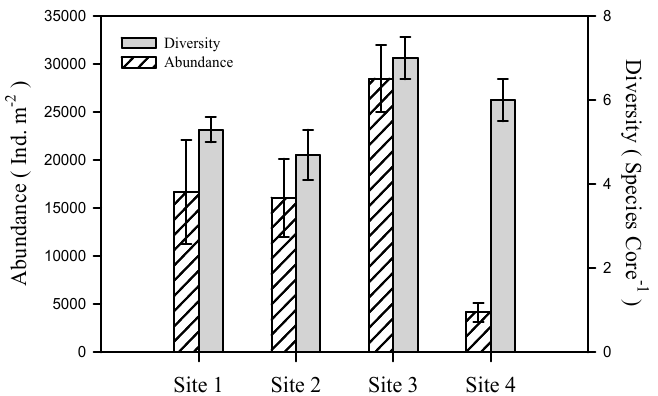
Figure 2. Taxonomic diversity (number of species per core) and total abundance of benthic macrofauna (ind. m − 2 ) in incubated cores from four study sites in the Sacca di Goro Lagoon (average ± st. error). − 2 Site 4 (316 ± 73 ind. m ) had the lowest abundance of macrofauna individuals (Figure 2) varying